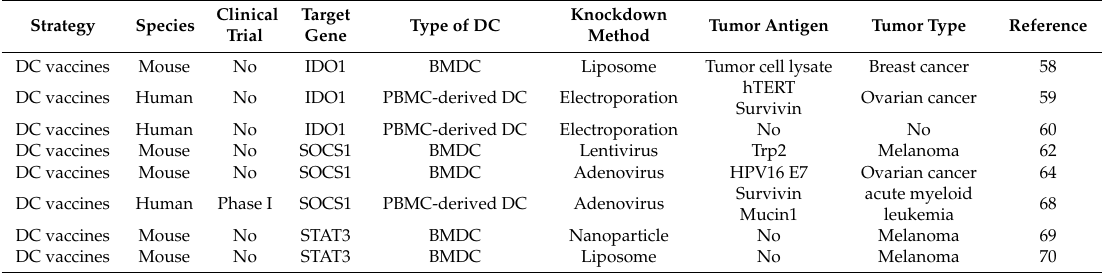
Table 1. Ex vivo silencing intracellular negative immune regulators of dendritic